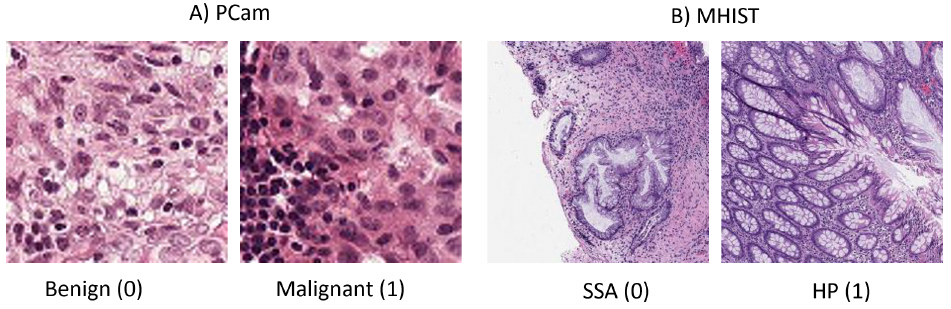
Figure 1. Two sample images from each of the two datasets. ( A ) Images from PCam. ( B ) Images from MHIST, with one for each